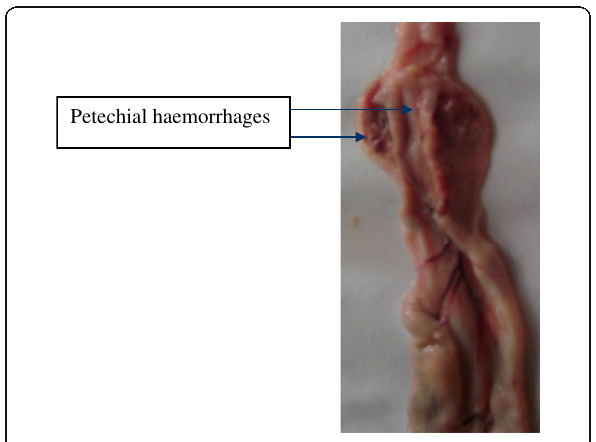
Fig. 1 Post-mortem lesion of NDV challenged control